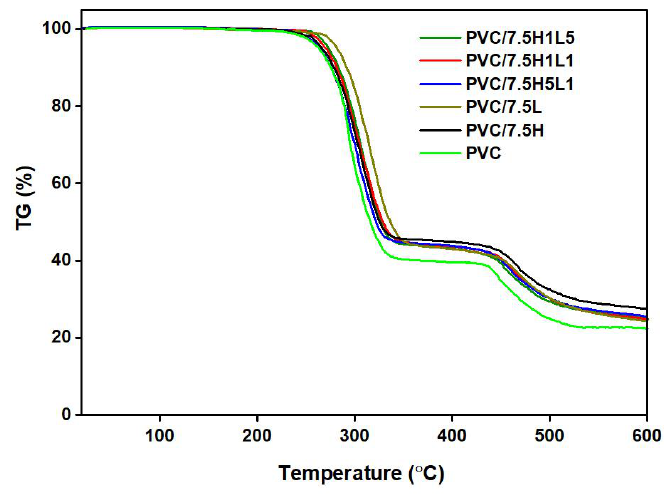
Figure 5. Exemplary TGA thermograms of PVC and PVC composites with 7.5wt% of fillers: lignin, halloysite and halloysite – lignin hybrids.